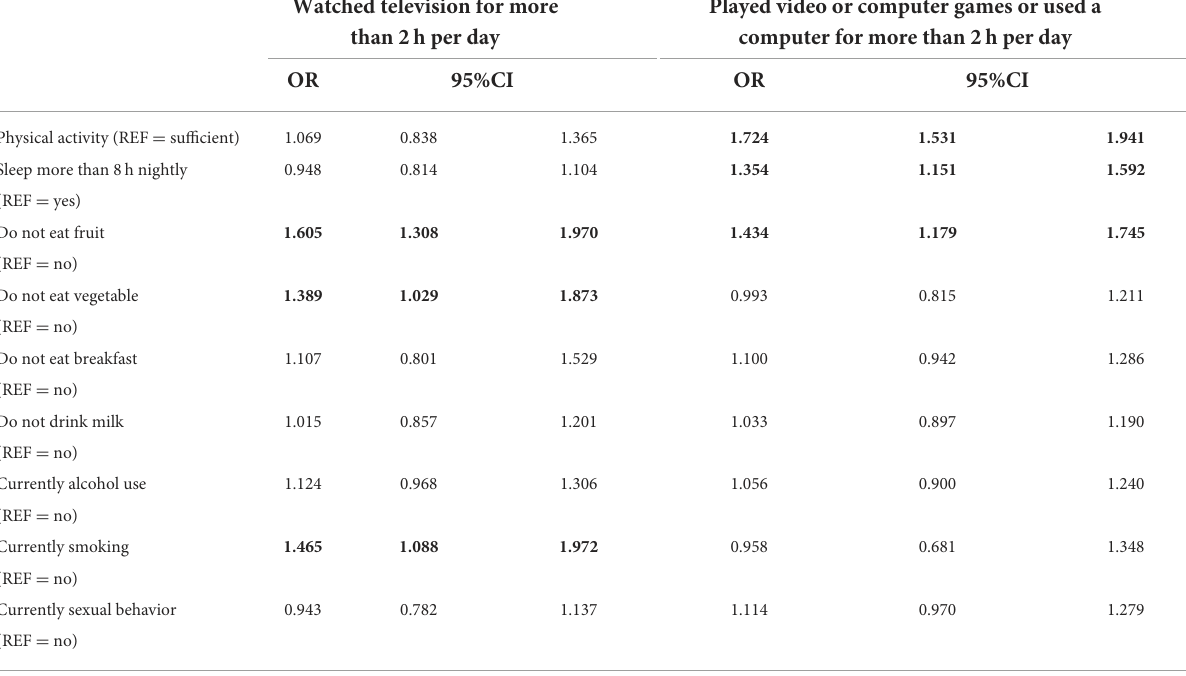
TABLE 3 Associations between with screen time and the selected lifestyle behaviors. Watched television for more than 2h per day